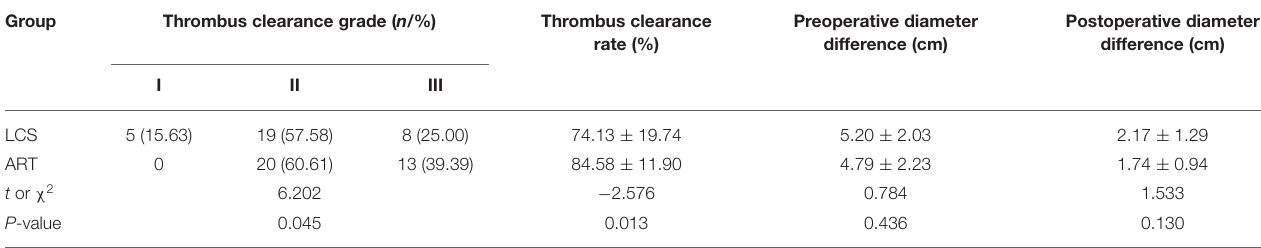
TABLE 3 | Comparison of curative effect of two groups of treatment